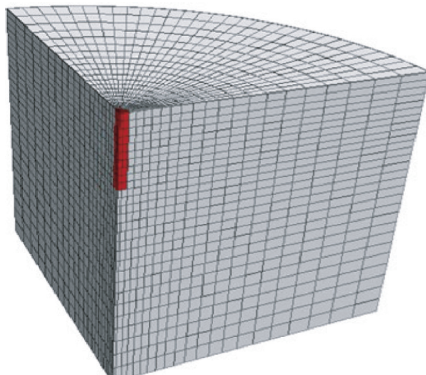
Figure 13: The meshing diagram of the numerical